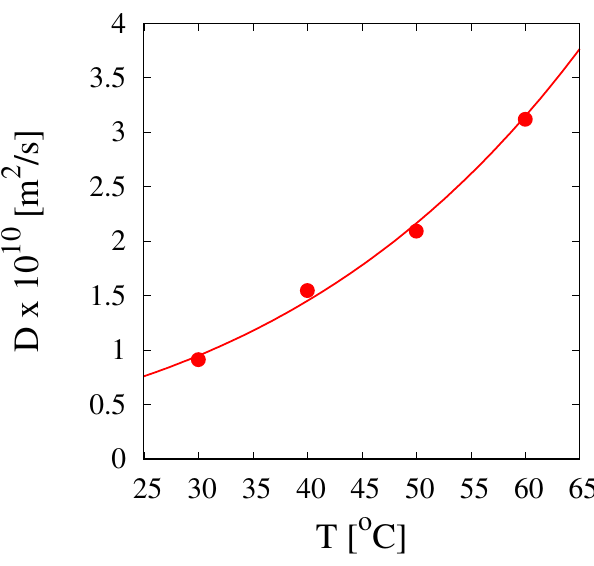
Figure 10. Diffusion coefficient D (m 2 /s) vs. dehydration temperature T ( ◦ C). Continuous line represents the Arrhenius behaviour D = D 0 exp [ − E / ( RT )] with D 0 = 5.77 × 10 − 5 m 2 /s and E / R = 4037.78 (K).